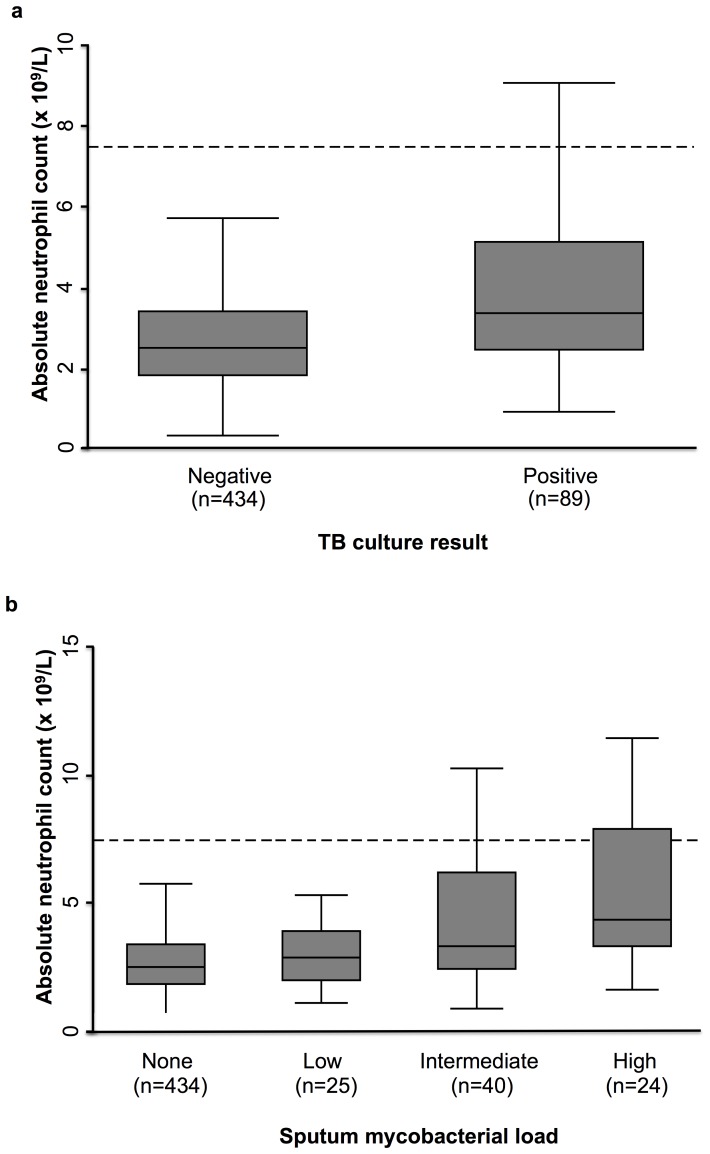
Box and whisker diagram of absolute neutrophil count among those (a) with and without pulmonary TB and (b) and among those with increasing levels of sputum mycobacterial load.The middle of the box represents the median value and the outer box edges represent the 25th and 75th percentiles (IQR). The ends of the whiskers represent the lower and upper adjacent values. Outliers as defined by any data point above the upper adjacent value, were excluded from both plots. The dashed line at ANC = 7.5×109/L represents the upper limit of the normal ANC range, above which is considered neutrophilia.